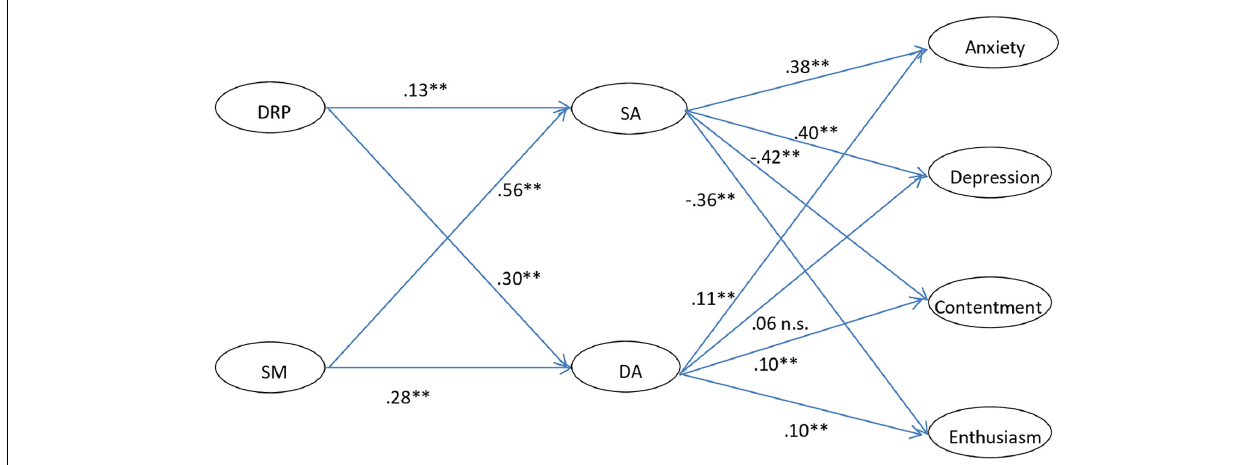
FIGURE 2 | The SEM results of the hypothesized model ( n = 1656). DRP, Display rules perception; SM, Self-monitoring; SA, Surface acting; DA, Deep Acting; n.s., not significant, ∗∗ p < 0.01; Goodness-of-fit index: χ 2 = 3079.59, df = 508, p = 0.00, RMSEA = 0.055, SRMR = 0.063, CFI = 0.91, TLI =